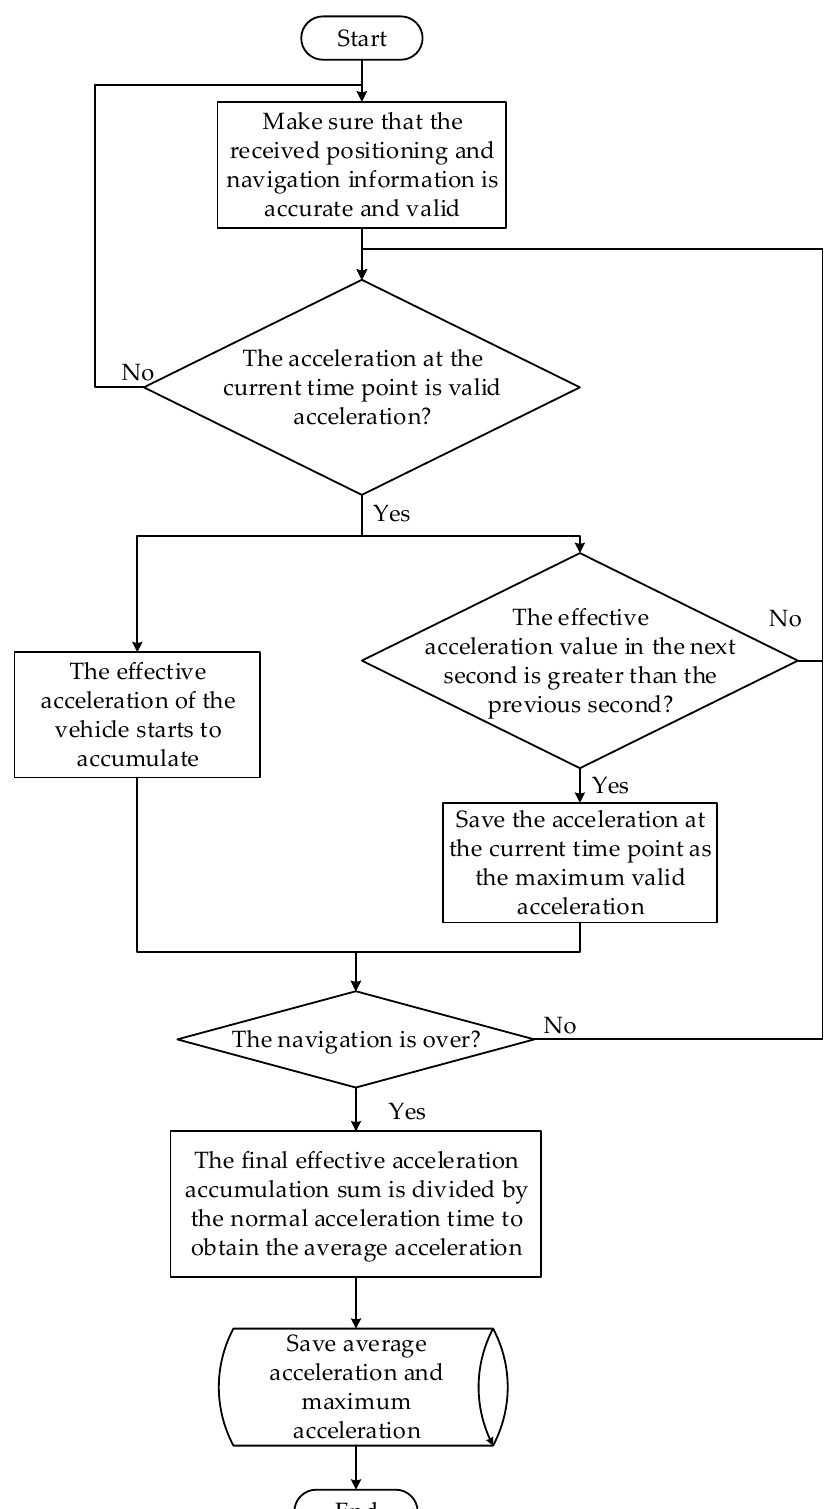
Figure 6. Flow chart of the average acceleration A ave and maximum acceleration A max acquisition algorithm.